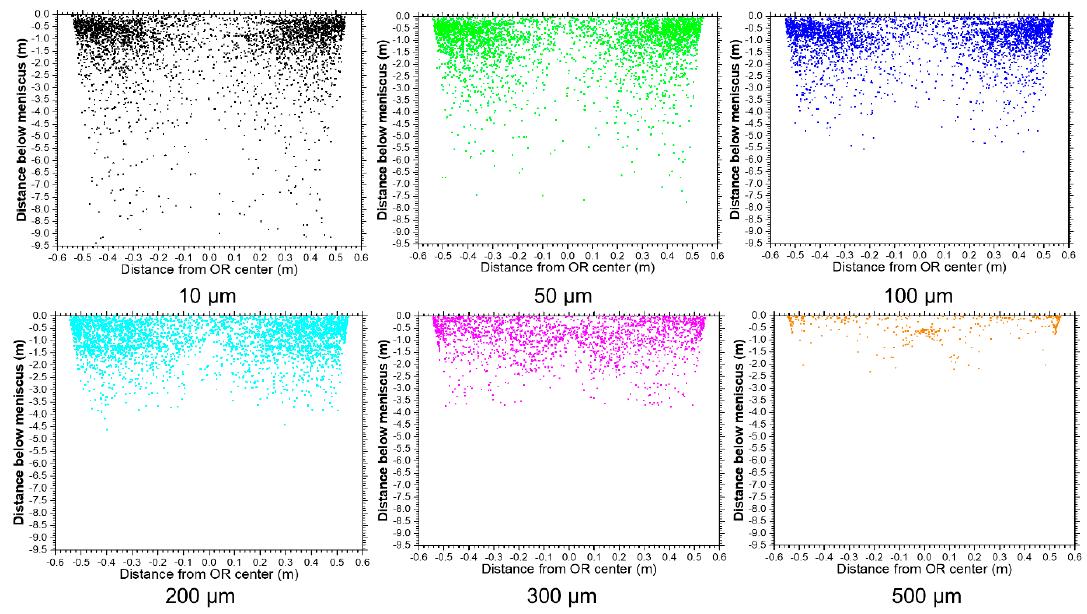
Figure 8. Inclusion capture locations on the OR shell, by inclusion size (front view).